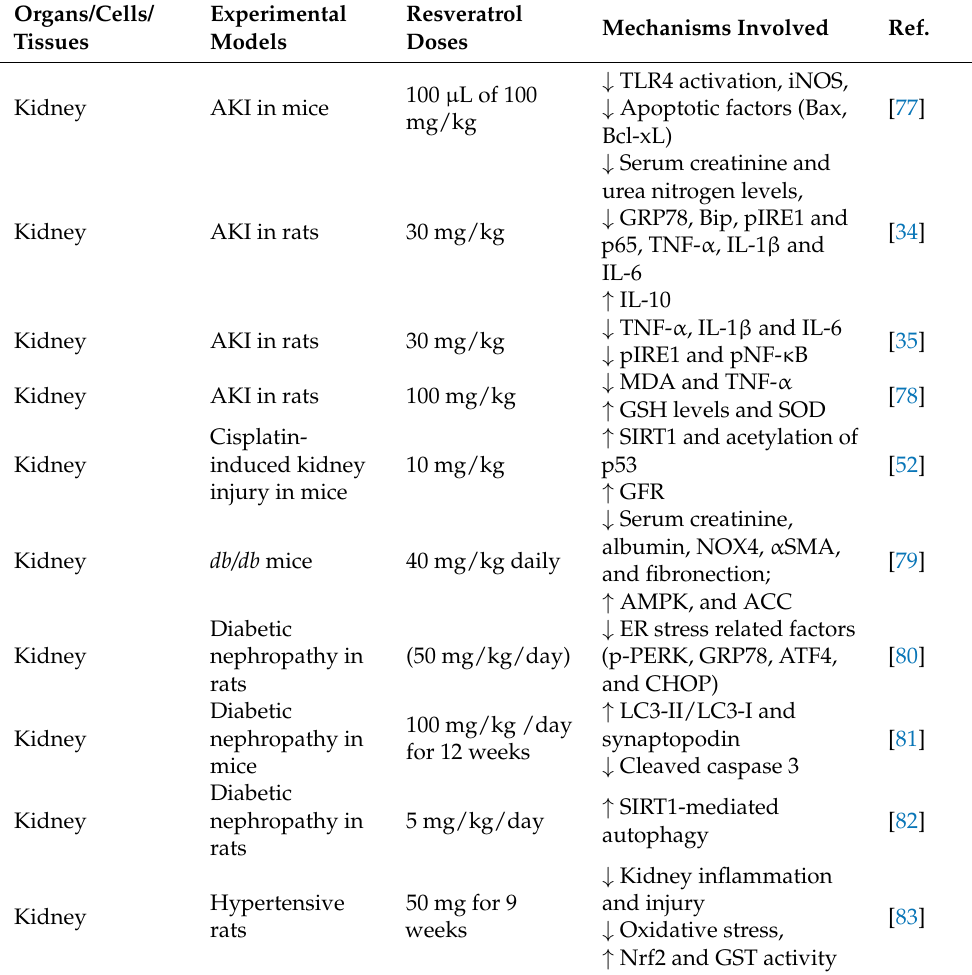
Table 2. Pharmacological effects of resveratrol on the aging process in kidney tissues or